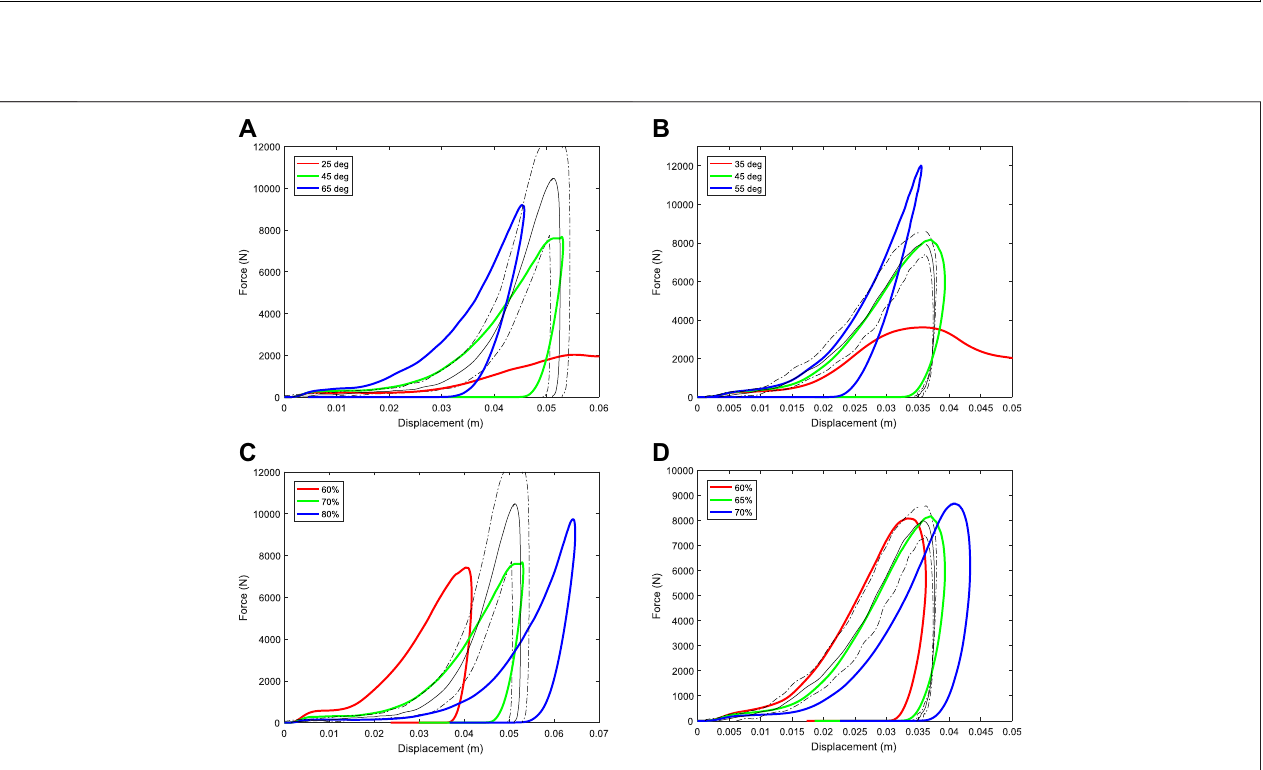
FIGURE 10 | Variation of force-displacement results for the simulated track testing device with changes to (A,B) bulk modulus and (C,D) cohesion parameters of the track. Results for the dirt track are shown in the left column (a, c) for the synthetic track are shown in the right column (b, d).